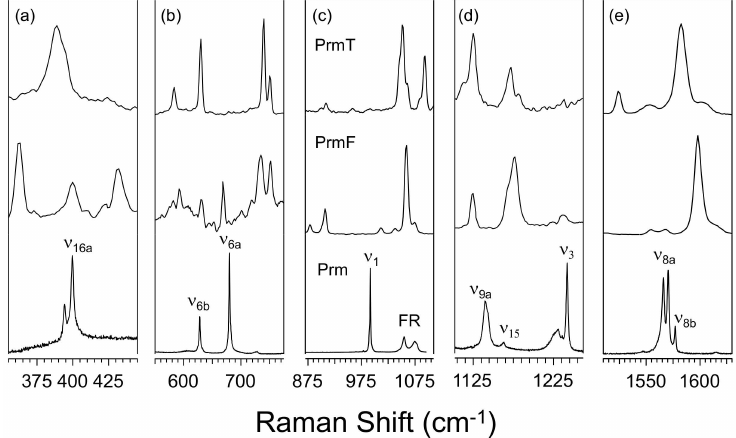
Figure 3. Experimental solid-state Raman spectra of pyrimidine (Prm) compared to that of its furan (PrmF) and thiophene (PrmT) analogues in the regions of ten of Prm’s normal modes. Modes previously assigned for Prm and Prm’s Fermi resonance (FR) are